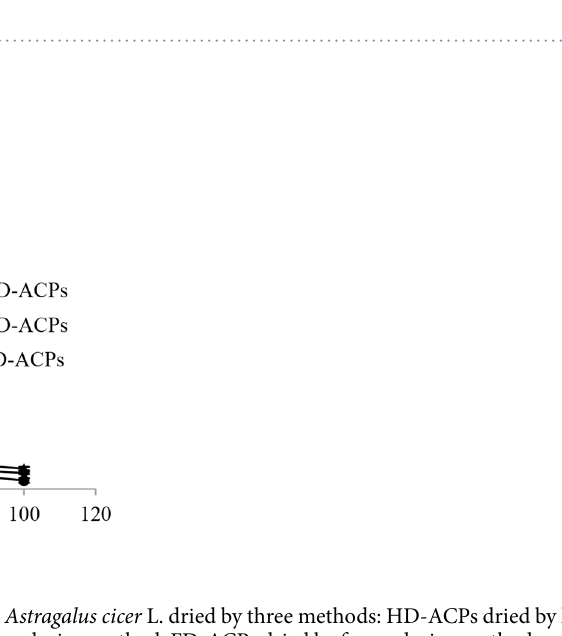
Table 3. The chemical composition of ACPs dried with three methods. The data is shown as the mean ± standard deviation (n = 3). Different superscripts in the same row indicate significant difference ( P < 0.05). HD-ACPs dried by hot air drying method; VD-ACPs dried by vacuum drying method; FD-ACPs dried by freeze drying method.